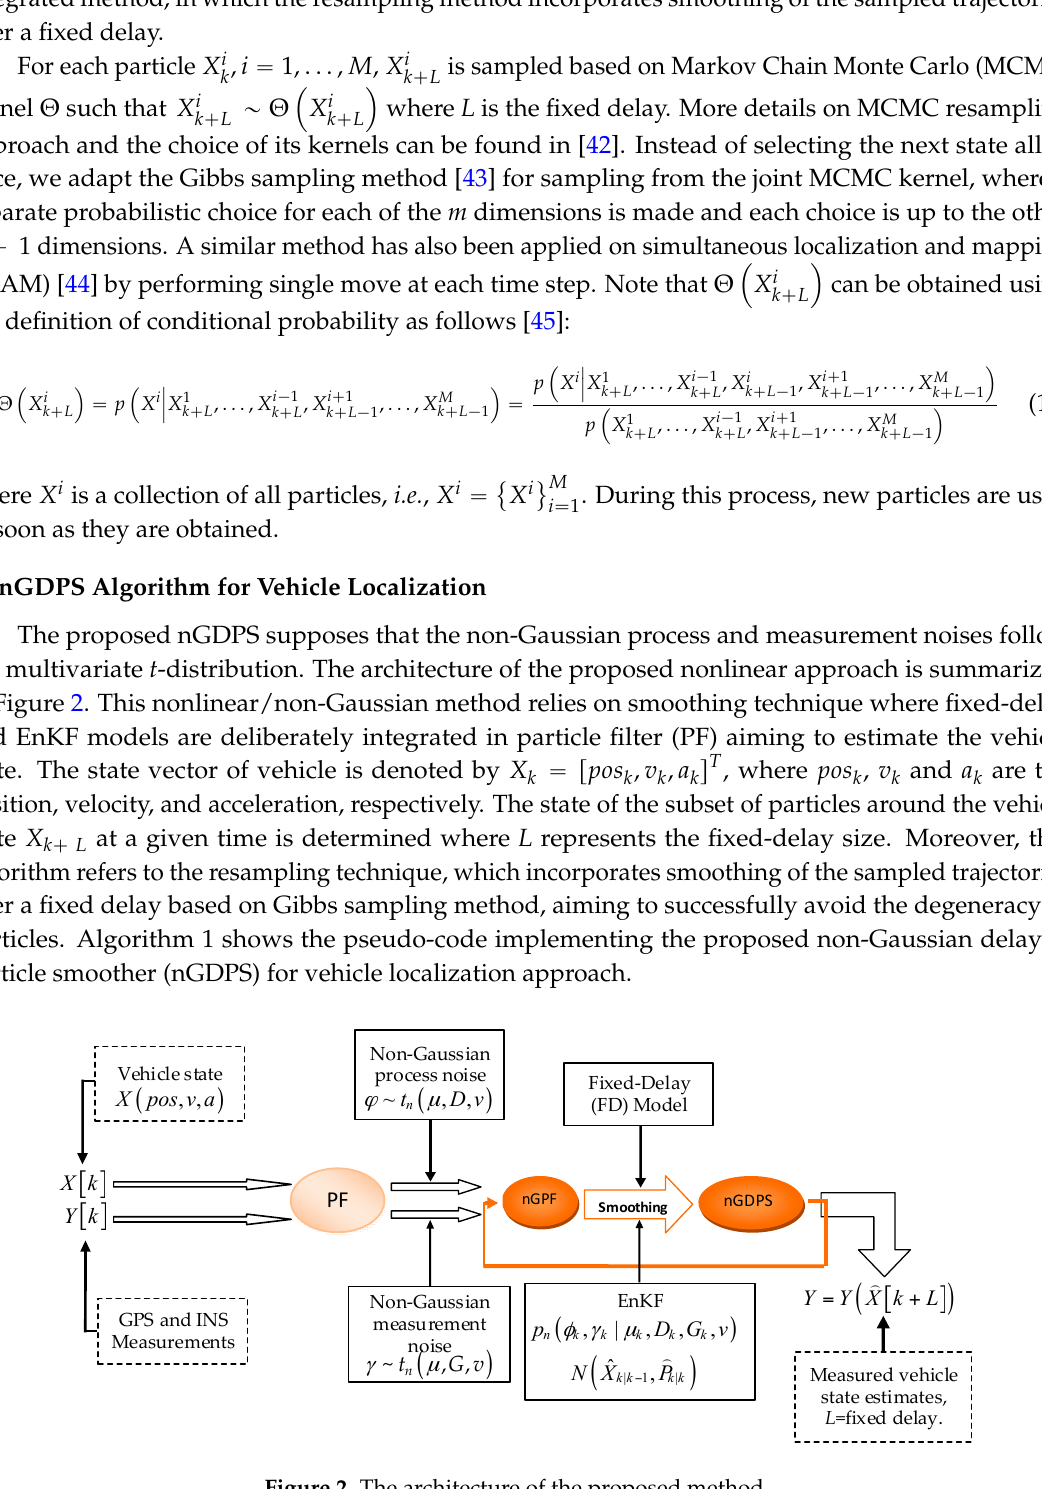
Figure 2. The architecture of the proposed method.